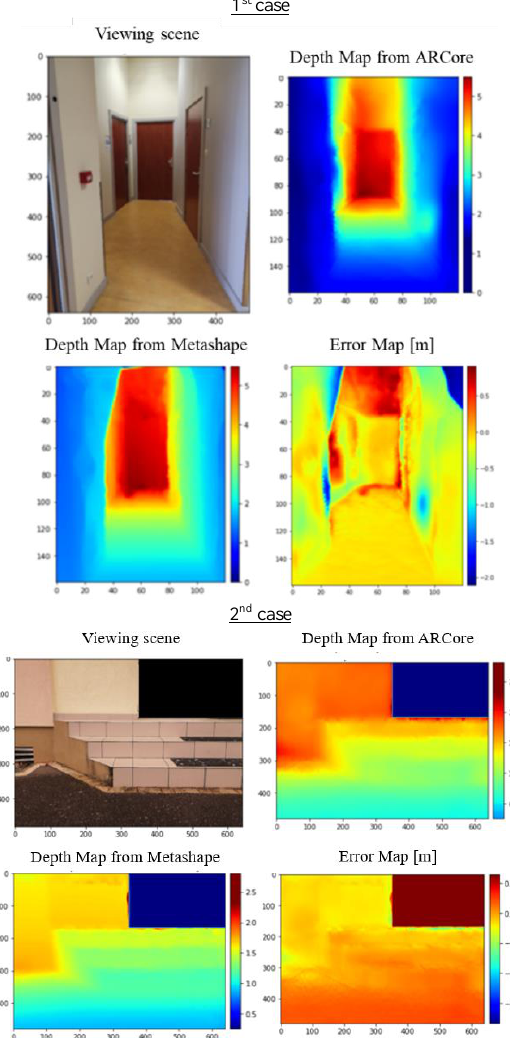
Figure 5. Two cases of analysis of depth results provided by ARCore